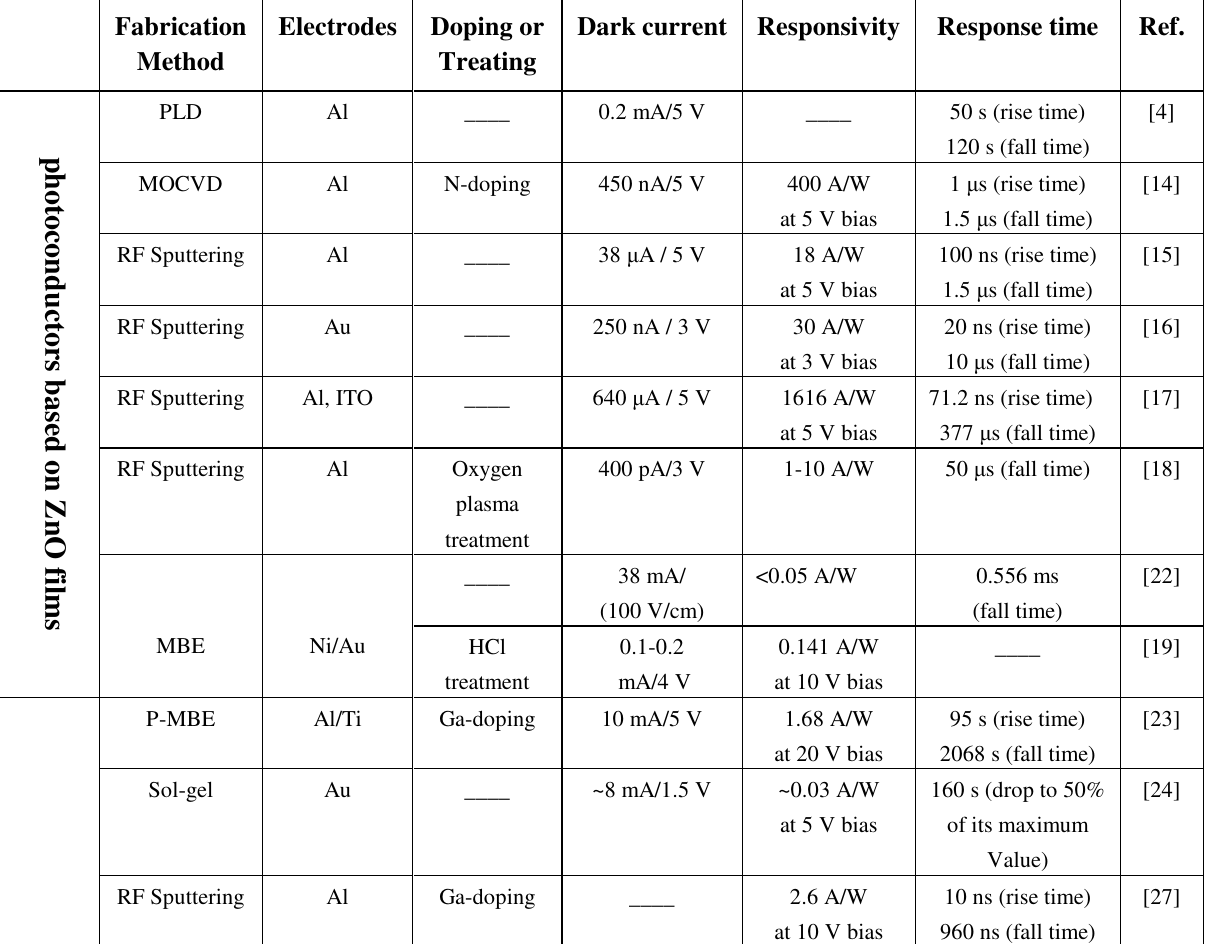
Table 1. Comparison of the ZnO photoconductors performance.